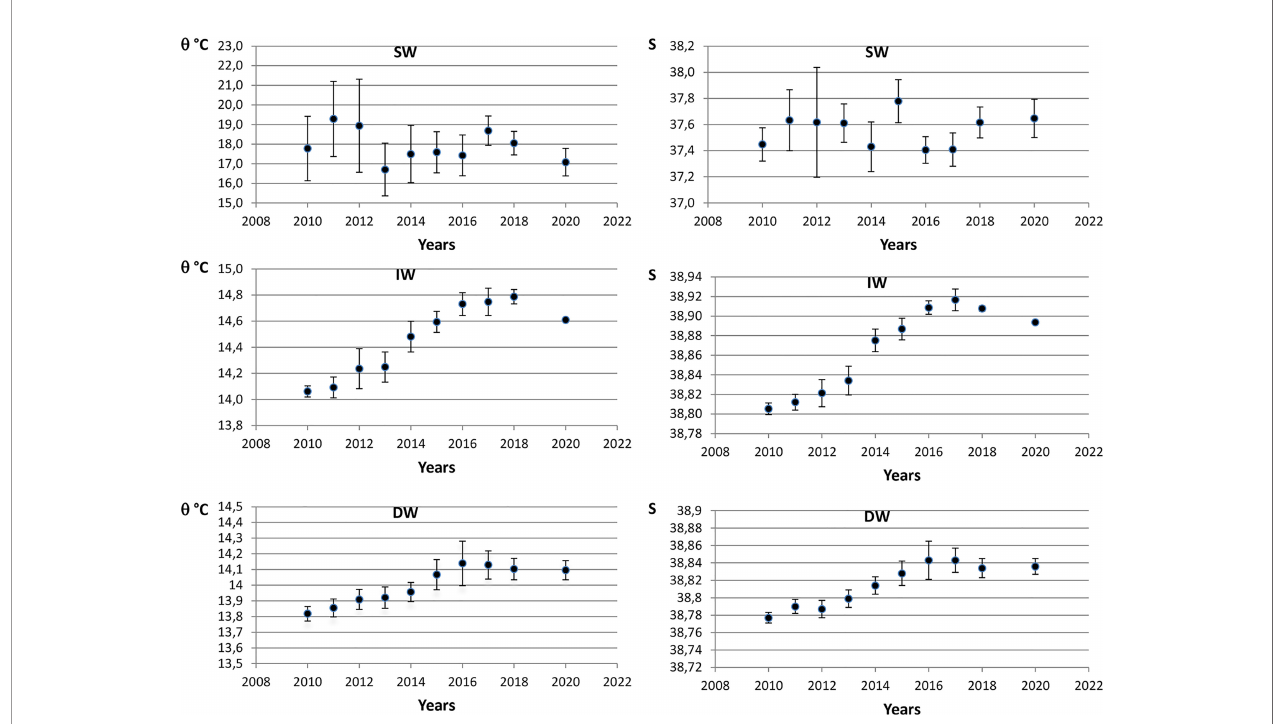
FIGURE 3 | Analysis of potential temperature (left panels) and salinity (right panels) time series computed by averaging over a water column of 10m below the S min for the SW and 100m below S max for the IW, which represent the core of the AW and LIW, respectively. For the DW was used the layer 500m-bottom. Bars indicate the standard